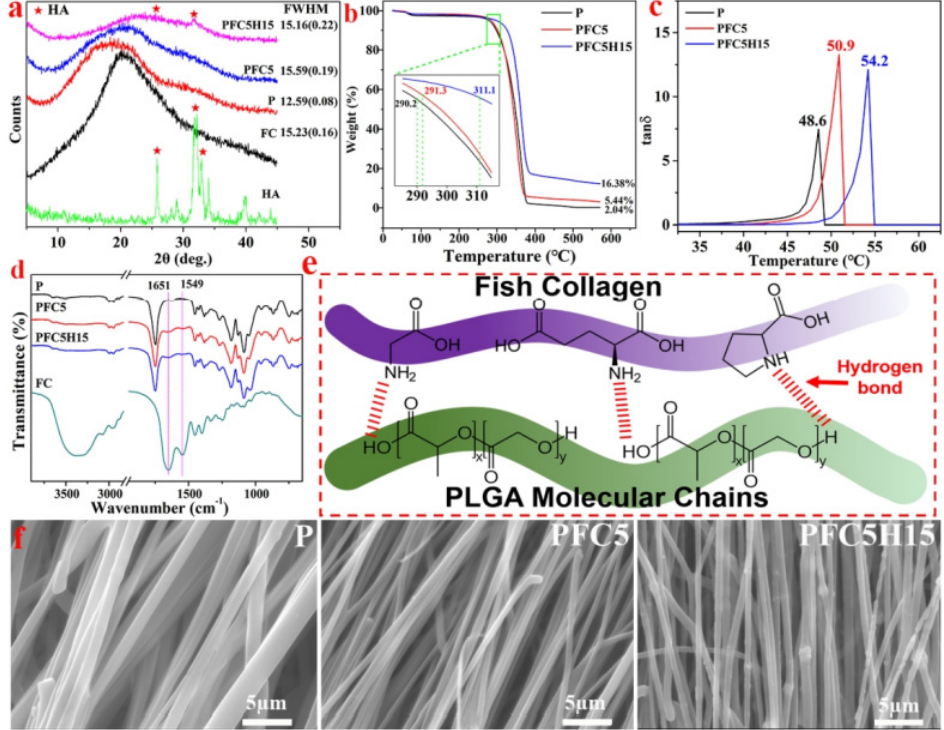
Figure 6. ( a ) The X-ray diffraction (XRD) patterns of HA, FC, and three different membranes; ( b ) the TG curve and ( c ) the DMA curve of the membranes illustrating the characteristics; ( d ) the FTIR spectra and ( e ) a schematic diagram of the P, PFC5, and PFC5H15 membranes and FC; ( f ) the morphology of the edge of a fiber fracture, reprinted from Ref. [69].